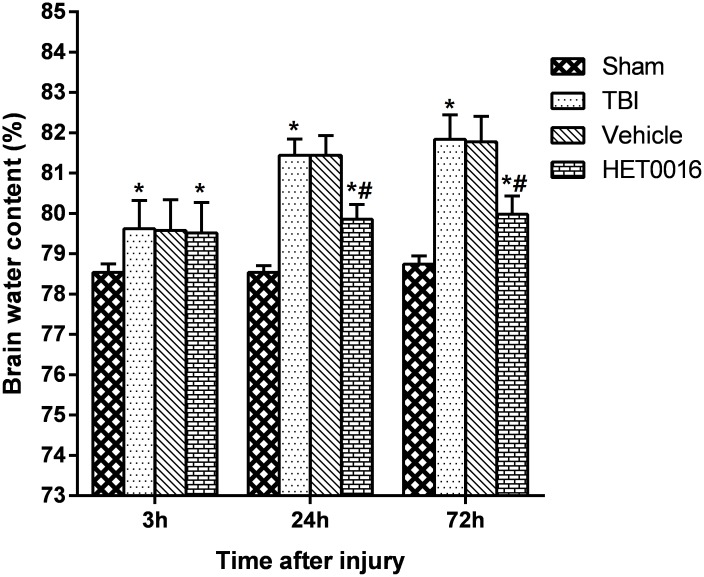
The effect of HET0016 on brain edema. Water content of traumatic brain tissues in the sham, traumatic brain injury (TBI), vehicle and HET0016-treated groups at 3, 24, and 72 h after injury. Data are shown as the mean ± SD. ∗P < 0.05 compared with the corresponding sham group at the same time point; #P < 0.05 compared with the vehicle-treated group.